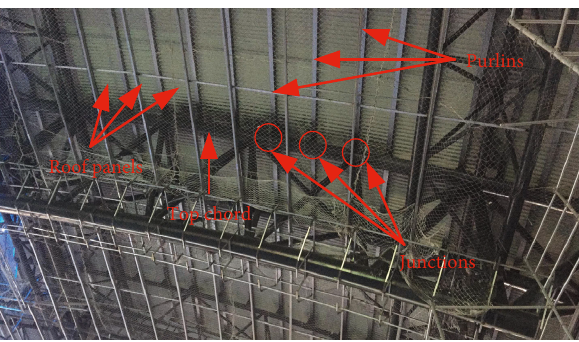
Figure 19: Steel structure roof.